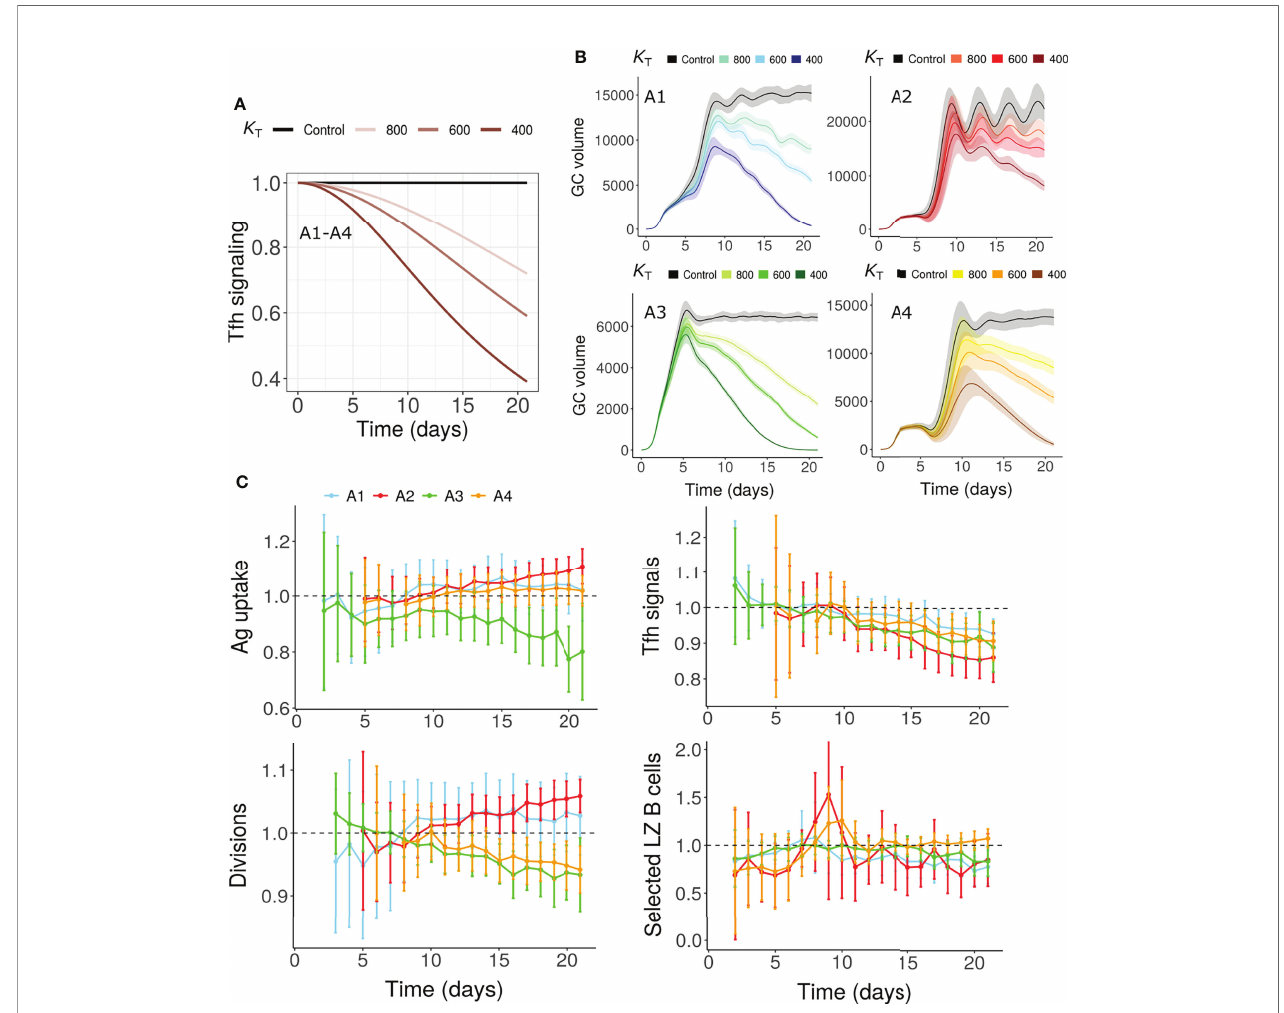
FIGURE 3 | GC shutdown due to changes in Tfh signaling intensity (Mechanism 5). (A) Maximum Tfh signaling intensity T max vs time according to Equation 8 in assumptions A1-A4. Values were normalized to the maximum signaling intensity at the start of the simulation. Colors represent different values of K T and black curve labelled control represents the control simulation where no decrease in Tfh signaling intensity was considered. K T is the time point in hours where the maximum Tfh signaling intensity decreases to half of its initial value (see Equation 8, Methods sections). (B) GC dynamics in assumptions A1-A4. Black curves represent control simulations. Different colors represent value of K T used in Equation 8 and are shown in labels above panel (B) Solid lines and shaded regions represent mean and standard deviation of 50 simulations, respectively. (C) Average antigen uptake per B cell, Tfh signals acquired per B cell, average number of divisions per recycling GC B cell and fraction of Tfh selected centrocytes (with K T = 600). Readouts were normalized with that of the control simulation. Colors represent the assumptions A1-A4. Error bars represent standard deviation of 50 simulations. GC, Germinal center; Tfh, T follicular helper cell; Ag, Antigen; LZ, Light